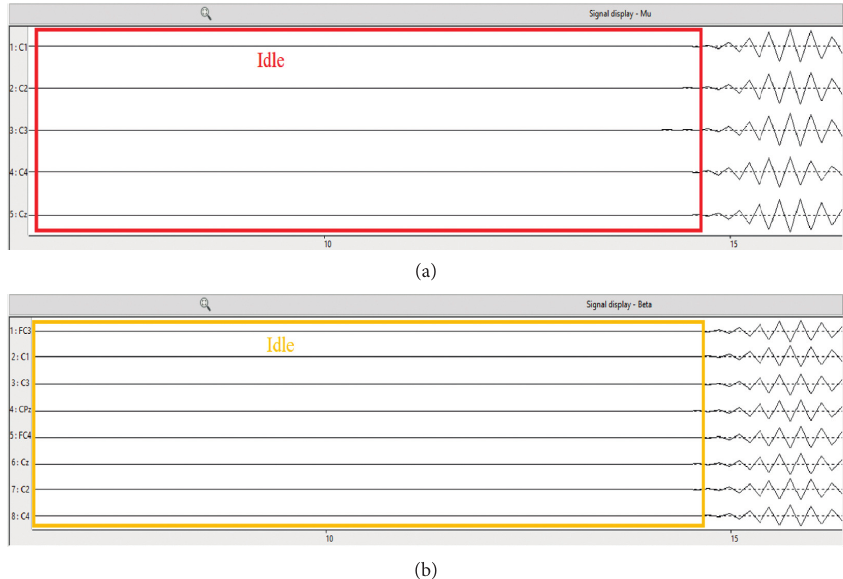
Figure 11: The behavior of the mu and beta rhythms at idle